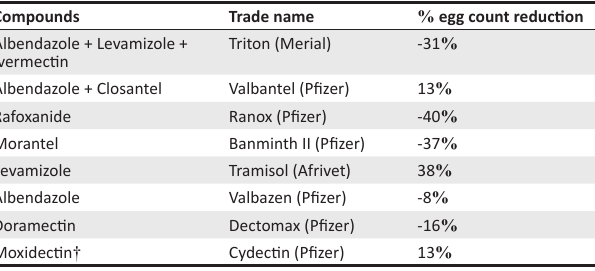
TABLE 2: Summary of the efficacy of various registered anthelmintics against the Stutterheim strain of H. contortus during 2005. Compounds